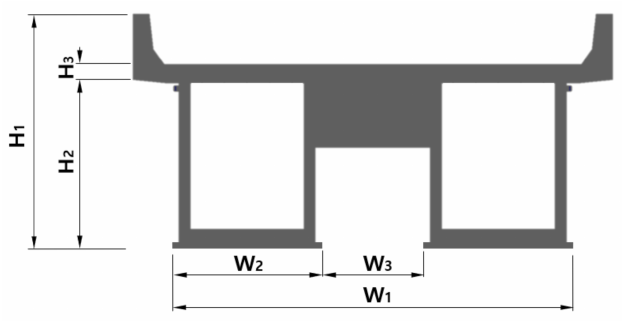
Figure 13. Design parameters for a steel box girder